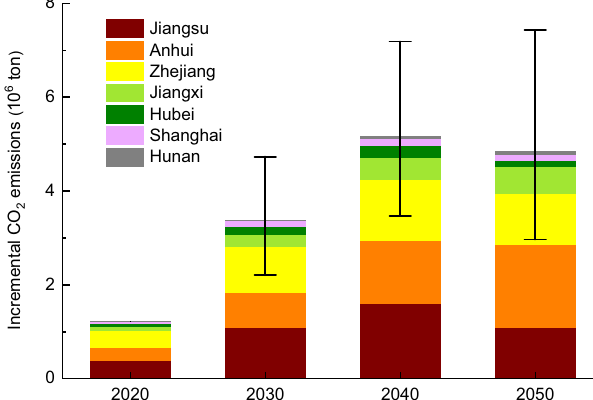
Fig. 3 Plum rain effects on the incremental CO 2 emissions (ICEs) from 2020 to 2050. The error bar de fi nes the range of the ICEs based on the generation and demand change trends fl uctuating by ±25% from 2030 to 2050 on the basis of the national average values.